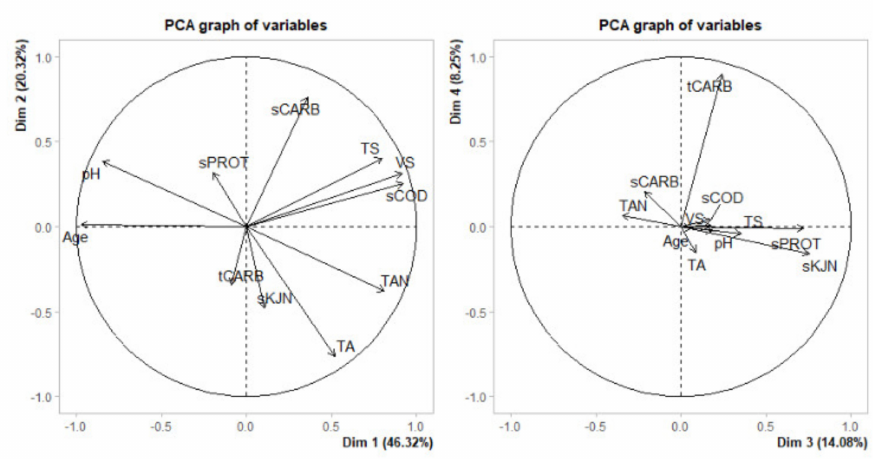
Figure 1. Principal component analysis (PCA) plot of the effect of digestate age on biochemical parameters. Table 3. Spearman correlation (top right) coefficients of the effect of age and the biochemical parameters and their interdependencies with blue and red representing strong positive (+1) and negative correlations ( − 1), respectively. The bottom left depicts the respective p -values with significant p -values in bold.